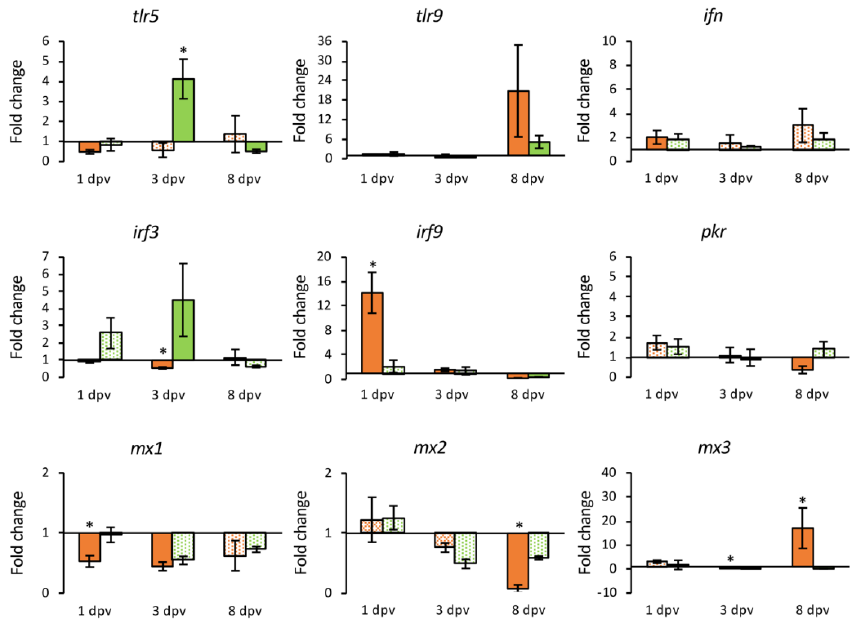
Figure 6. Relative expression levels (2 − ∆∆ Ct ) of TLR-coding genes and type I interferon related genes in the head kidney from vaccinated (orange) and mock-vaccinated (green) fish at different times post-vaccination (dpv). Differentially expressed genes (DGEs) are represented in solid color. Data are expressed as mean ± SEM (n = 5). Significant differences are indicated by an asterisk ( p < 0.05).